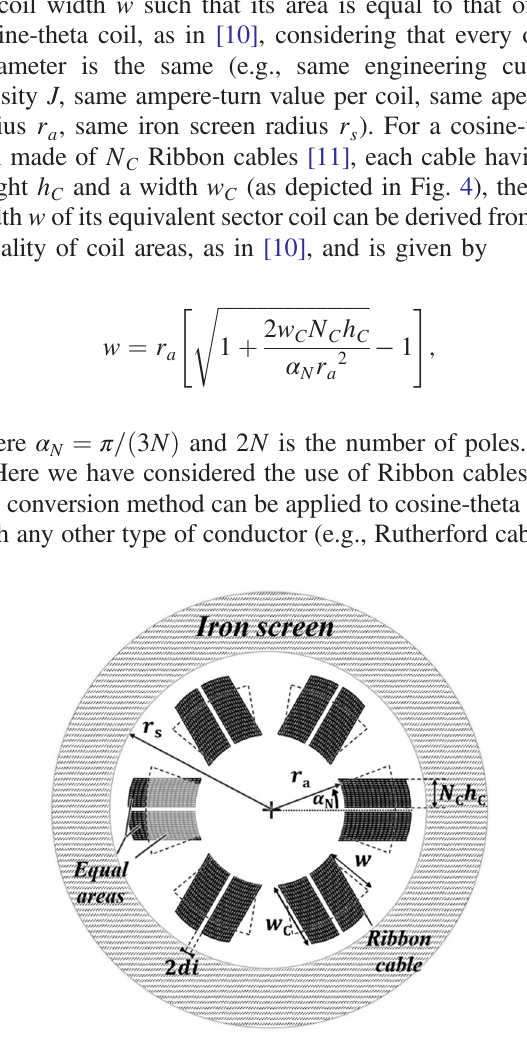
FIG. 4. Sketch of a 2 N -poles cosine-theta magnet with iron screen and its equivalent sector coil (dashed lines) for N ¼ 3 (i.e.,